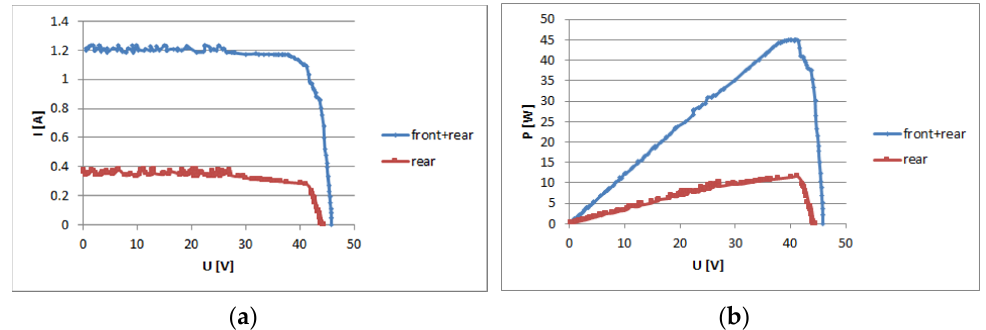
Figure 14. The whole vs. rear side yield characteristics benchmark in a bifacial module: ( a ) current- voltage characteristics; ( b ) power-voltage characteristics for 75° inclination over the foil substrates.